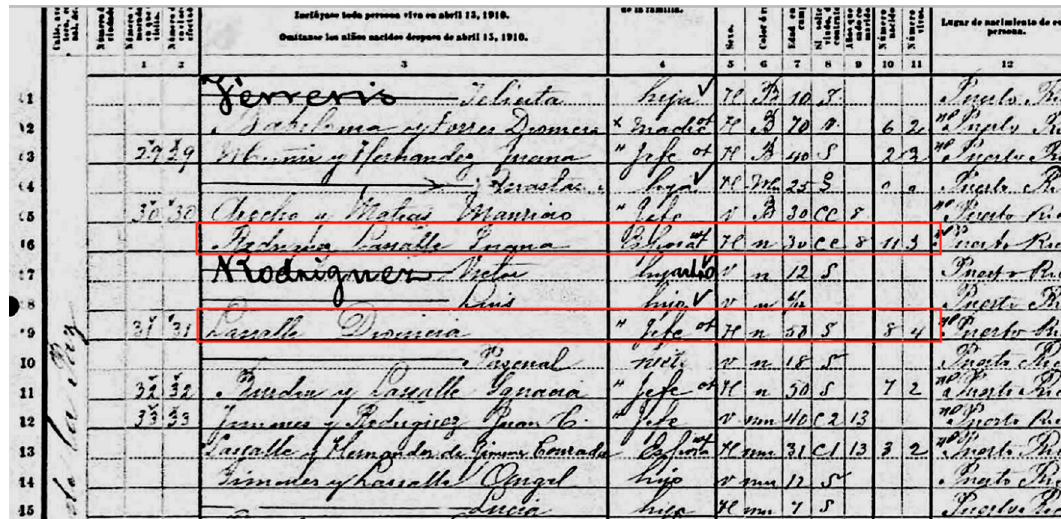
Figure 10. Households of Juana Rodriguez Lassalle, Line 16, and Dionicia [Leoncia] Lassalle, Line 19. Calle de la Paz, Barrio Pueblo, Moca, 1910 US Federal Census. United States Census, 1910, database with images, FamilySearch (https://familysearch.org/ark:/61903/1:1:VWKB-4H3: accessed 15 January